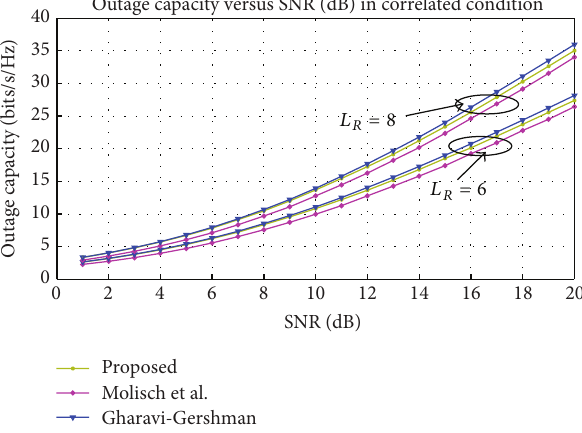
Figure 9: Plots showing the variation of outage capacity versus SNR in dB for, 𝑀 𝑇 = 16 , 𝑀 𝑅 = 16 and 𝐿 𝑅 = 6 and 8 under correlated